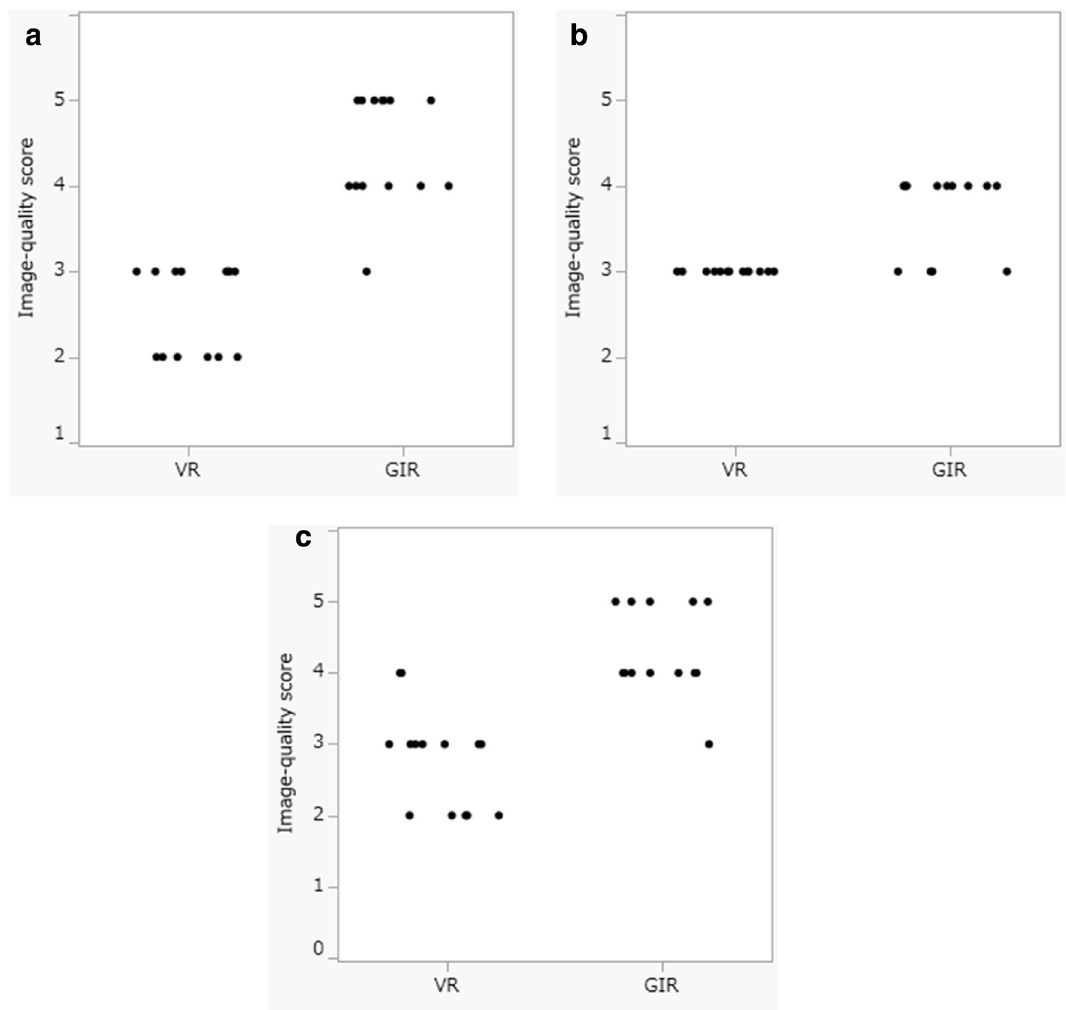
Figure 1. Overall image-quality scores of VR and GIR images of 14 stabbing victims. (( a ) Radiologist 1, ( b ) Radiologist 2, ( c ) Radiologist 3). The image-quality scores for the 3D effect and for smoothness of the skin surface were significantly higher on 3D CT GIR than 3D CT VR images (median image-quality scores: VR = 3 vs GIR = 4, p <